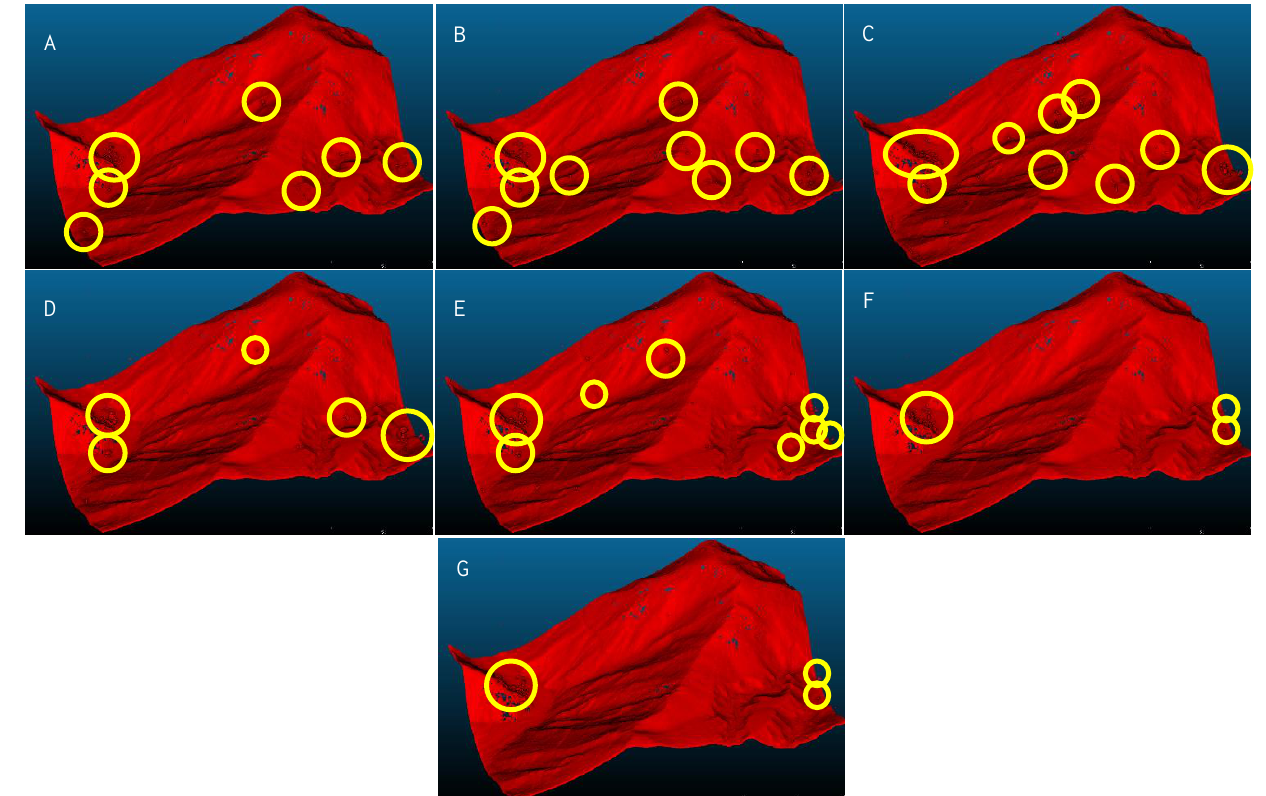
Figure 7. Resulting ground surface by each network (A-G)